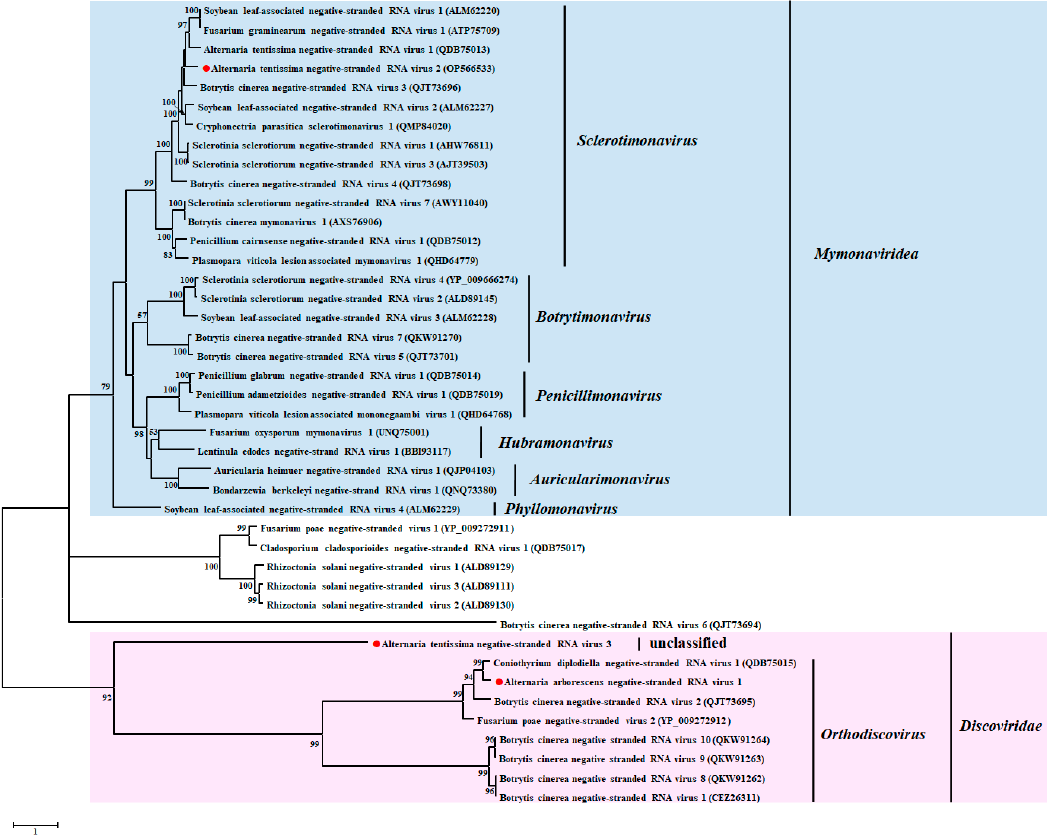
Figure 6. Phylogenetic analyses of the RdRp sequences including the novel − ssRNA mycoviruses and other selected viruses. We used the maximum likelihood method to conduct 1000 bootstrap replications. The data coverage percentage was shown by the numbers on the left of branches. The position of viruses AtNSRV2, AtNSRV4, and AaNSRV1 were shown by the red circle ( • ). We constructed the phylogenetic tree based on the best-fit protein evolution (LG+G+F) model and set the gamma value was